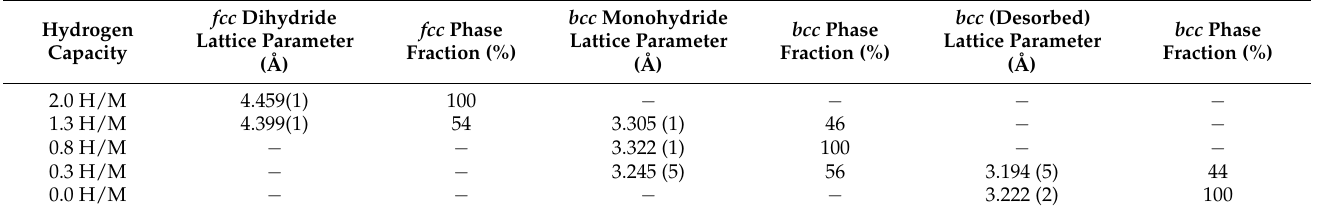
Table 4. Structural analysis (phase fractions and corresponding lattice parameter) of the